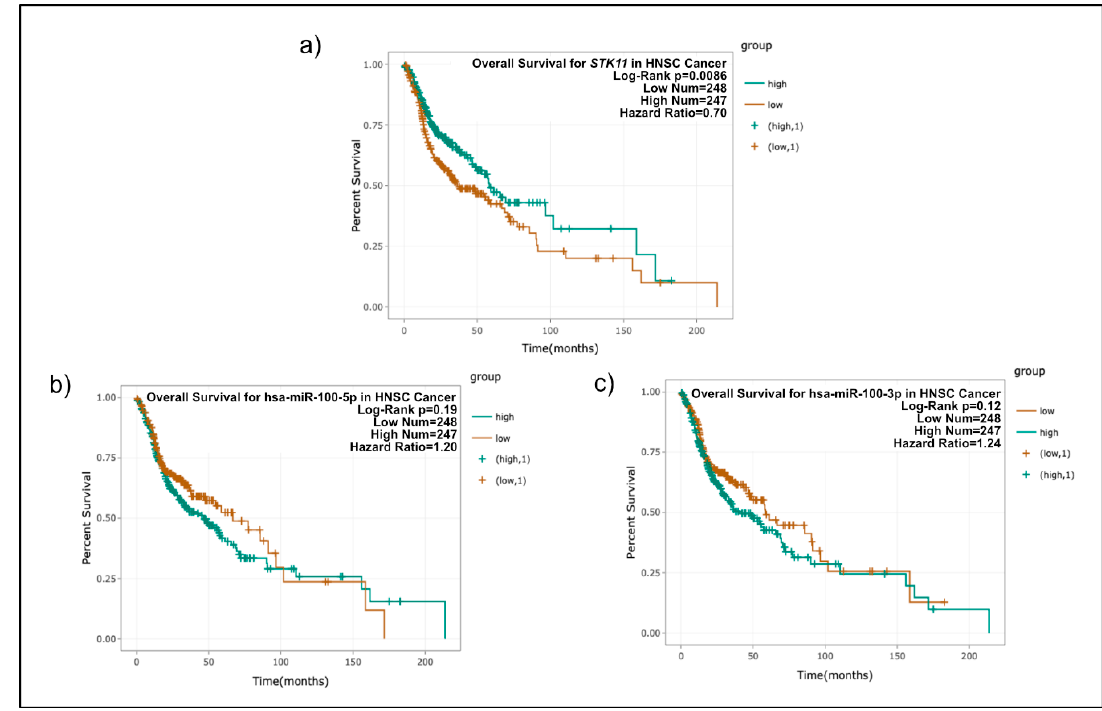
Figure 6. Overall survival TCGA analysis of ( a ) STK11, ( b ) miR-100-5p, and ( c ) miR-100-3p in head and neck cancer. The expression values of genes from RNA-seq data were scaled with log2 (FPKM + 0.01).